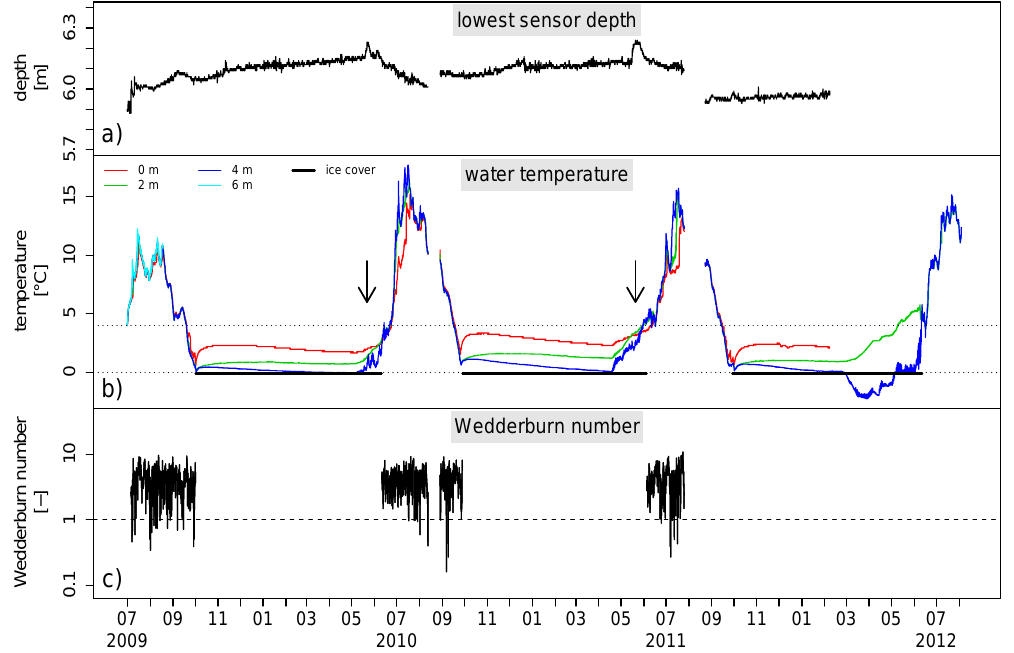
Figure 4. Hourly physical characteristics for Sa_Lake_1, July 2009 to August 2012. (a) Depth of bottom lake sensor as an indicator of water level changes; (b) water temperatures and ice cover duration; (c) Wedderburn number (dimensionless), calculated for the ice-free period only. Arrows indicate the timing of the lake’s seasonal flooding by Lena river